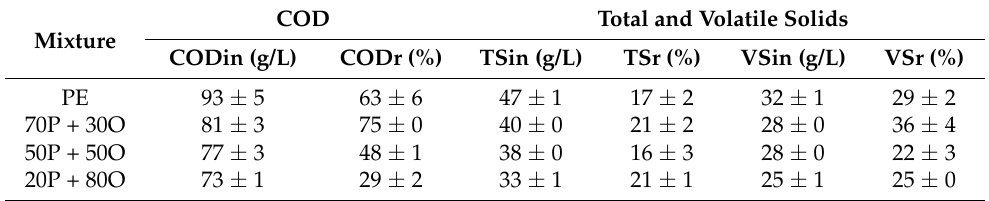
(Table 5) than PE without mixtures. The mitigating inhibitory effects were also reported when complementary substrates were anaerobically digested [46]. Table 5. Anaerobic digestion of PE + OMW: Performance and biogas/methane production. Mixture